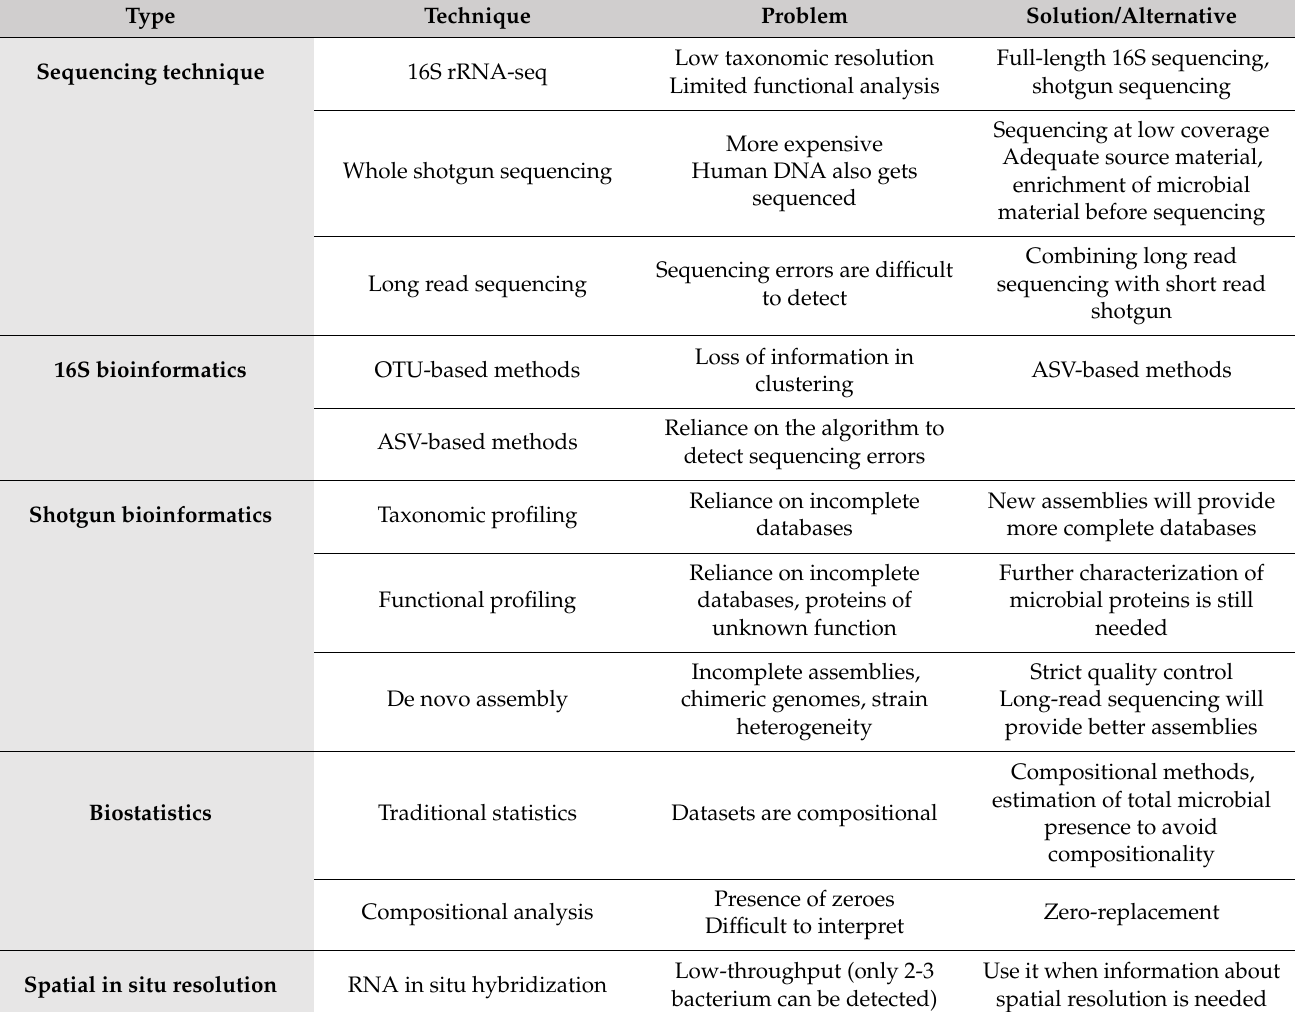
Table 2. Methodology for microbiome analysis: problems and